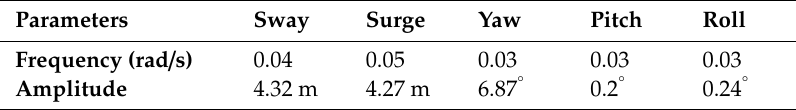
Table 2. Six DOF oscillation motion parameters for low frequency